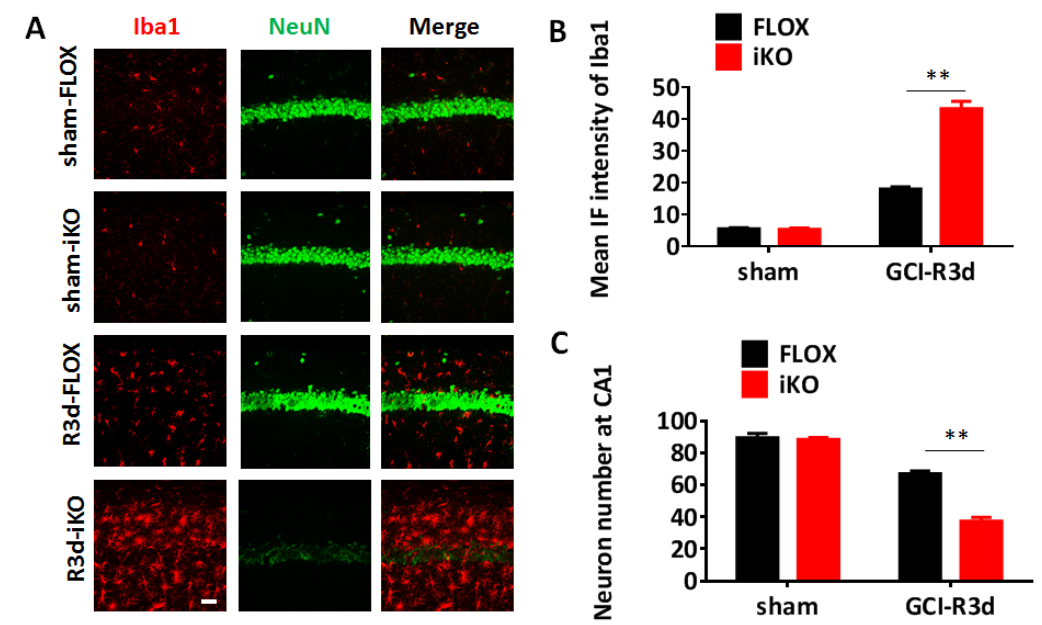
Figure 4. GFAP-ARO-iKO mice exhibit enhanced neuronal loss and microglial activation after GCI. ( A ). Representative images of NeuN and Iba1 immunostaining in the sham or R3d hippocampus and CA1 regions of male FLOX and GFAP-ARO-iKO mice. ( B ). Quantification of mean immunofluo- rescence (IF) intensity of Iba1. ( C ). Quantification of CA1 neuron number by NeuN staining. Scale bars: 20 µm. n = 6–8 animals/group. ** p < 0.01 compared to FLOX, two-way ANOVA followed by post hoc.